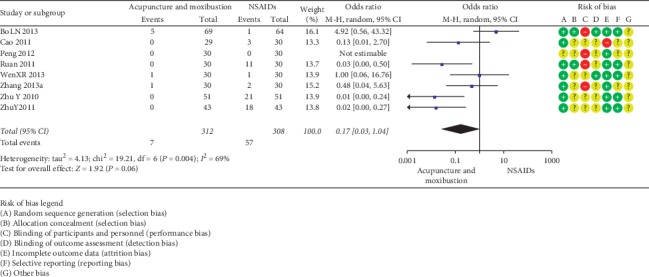
Acupuncture and moxibustion vs. NSAIDs.